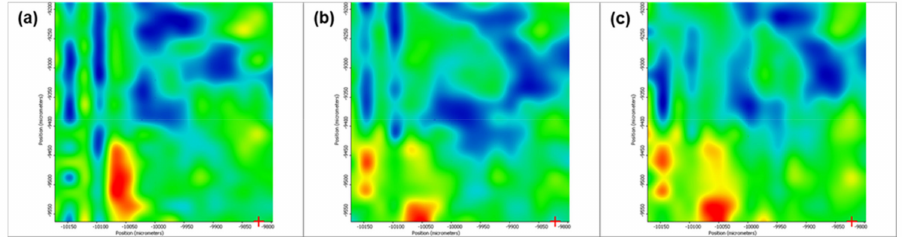
Figure 10. Second derivate IR mappings of Fe 3 O 4 @ β -CD/PTX thin films deposited at F = 300 mJ/cm 2 : surface intensity distribution of ( a ) 2930 cm − 1 , ( b ) 1029 cm − 1 and ( c ) ester/ketonic carbonyl vibration at 1739 cm − 1 .